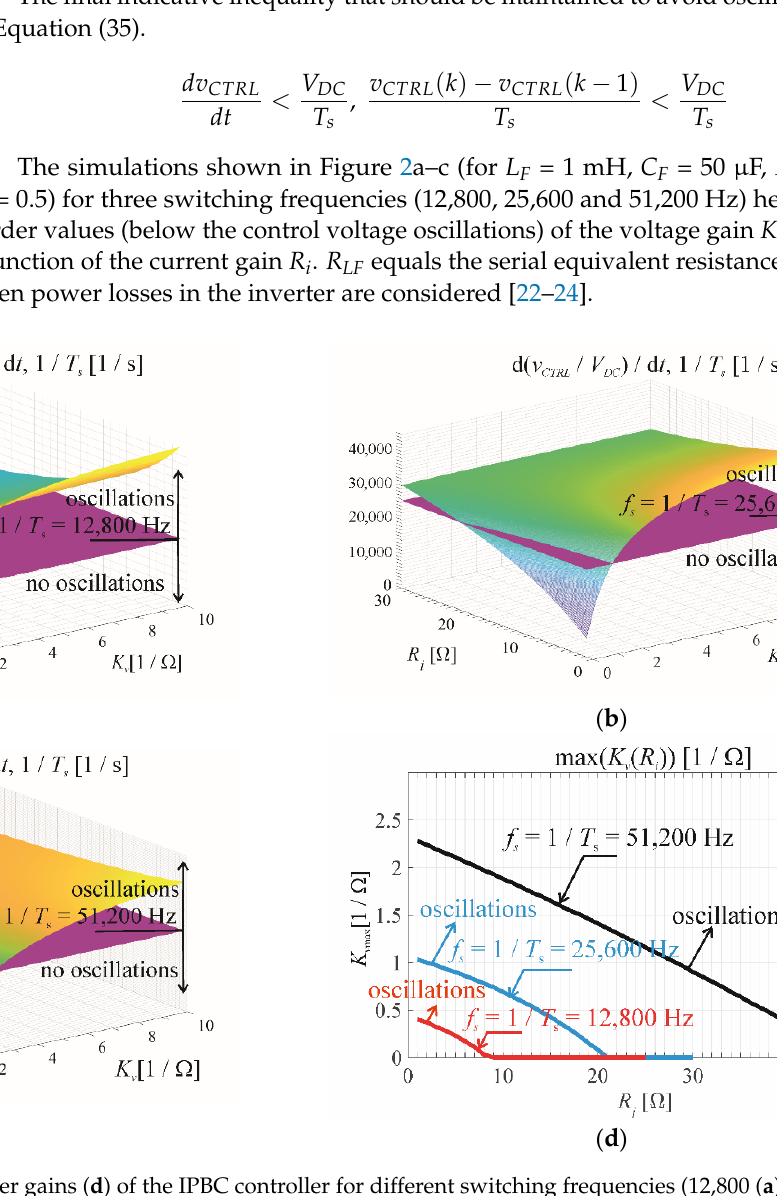
Figure 2. Determining the border gains ( d ) of the IPBC controller for different switching frequencies (12,800 ( a ), 25,600 ( b ), and 51,200 Hz ( c )) when L F = 1 mH, C F = 50 μ F, R LF = 1 Ω , and M = 0.5.